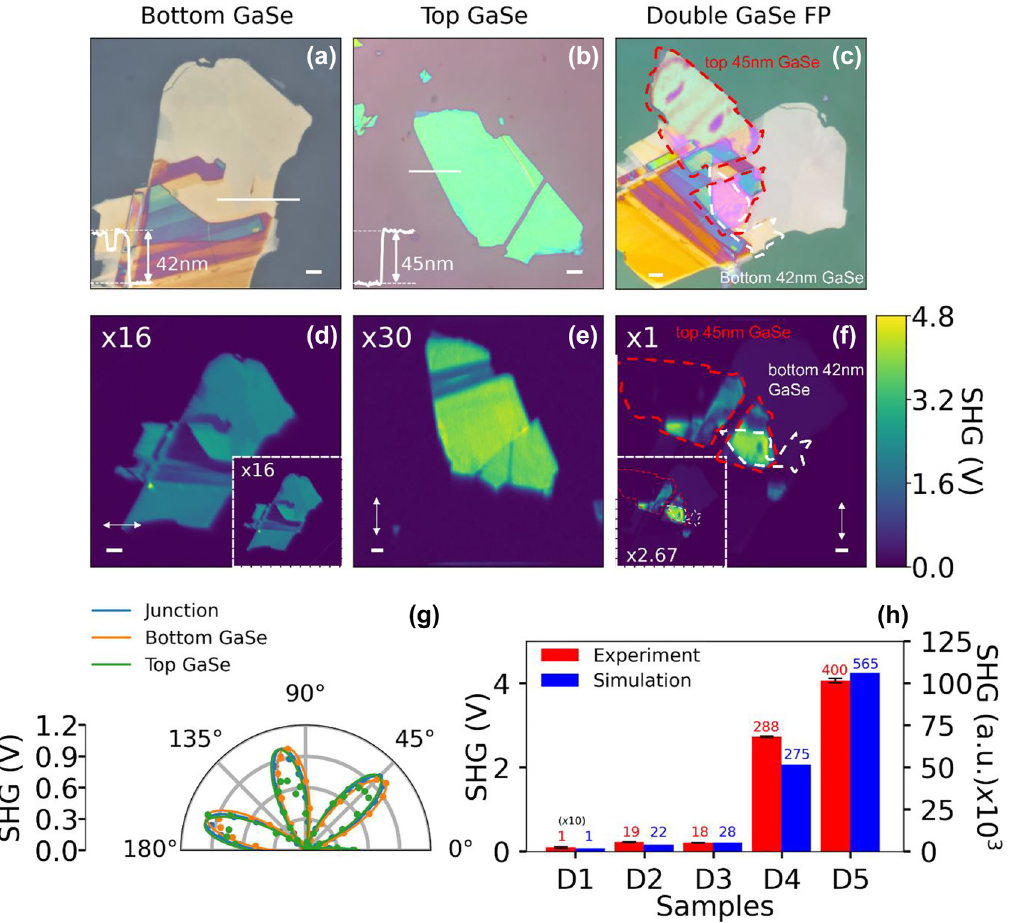
Figure 4: Summary of the experimental studies on the double GaSe FP structure. Optical images of samples: (a) 42 nm bottom GaSe/130 nm SiO 2 without PMMA coating, (b) 45 nm top GaSe on PMMA coated substrate and (c) 270 nm PMMA encapsulated double GaSe FP structure. The red and white dashed outline highlights the region of interest for the top GaSe and bottom GaSe. SHG images of: (d) 190 nm PMMA spacer coated 42 nm , (e) 45 nm top GaSe on PDMS sheet and (f) 270 nm PMMA encapsulated double GaSe FP structure with the dashed outline bottom GaSe/130 nm SiO 2 delineating the top and bottom GaSe. Insets in (d, f) show the SHG image of the double GaSe FP structure without the PMMA layer. The armchair direction for both the top and bottom GaSe layers is indicated by the double-sided arrow. Scale bar for all optical and SHG image correspond to 5 μ m. (g) Polar plot showing PSHG data correspond to top GaSe (green curve), bottom GaSe (orange curve) and the overlap region (blue curve) as a function of incident fundamental polarization angle. The circles show the experimental data and solid curves show the cos 2 (3 𝜃 ) fit. (h) Bar-graph comparing experimental (red bars) and simulated (blue bars) SHG signal strength at different stages of fabrication of the double GaSe FP structure. The samples , D2: 42 nm bottom GaSe/130 nm SiO , D3: 190 nm PMMA/42 nm considered for comparison are: D1 (reference sample): 40 nm GaSe/300 nm SiO 2 2 , D4: 45 nm top GaSe/190 nm PMMA/42 nm bottom GaSe/130 nm SiO , and D5: 270 nm PMMA/45 nm top GaSe/190 nm bottom GaSe/130 nm SiO 2 2 . The SHG enhancements factors for experiments and simulations are indicated on top of each bar PMMA/42 nm bottom GaSe/130 nm SiO 2